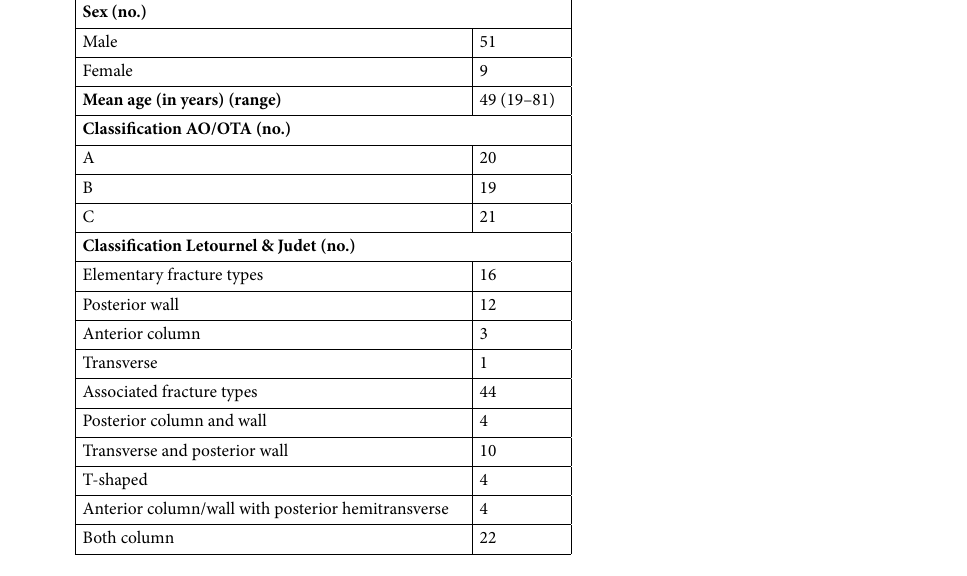
Table 1. Patients’ demographics.